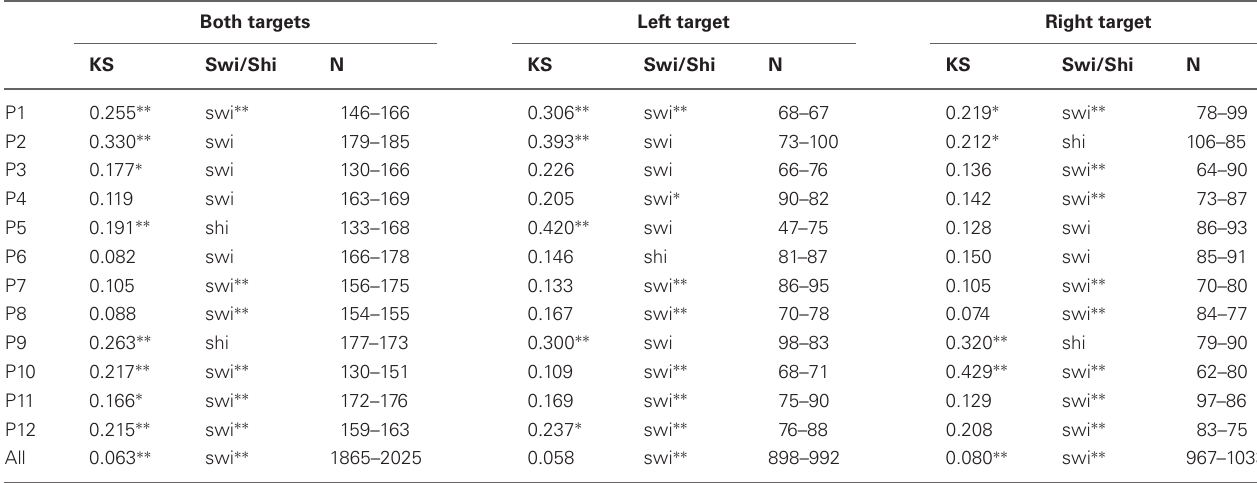
Table 5 | D -values of Kolmogorov-Smirnov (KS), and Swivel vs. Shift (Swi/Shi) tests on recinormal latency distributions between pre- and post-periods for every participant and the group of participants